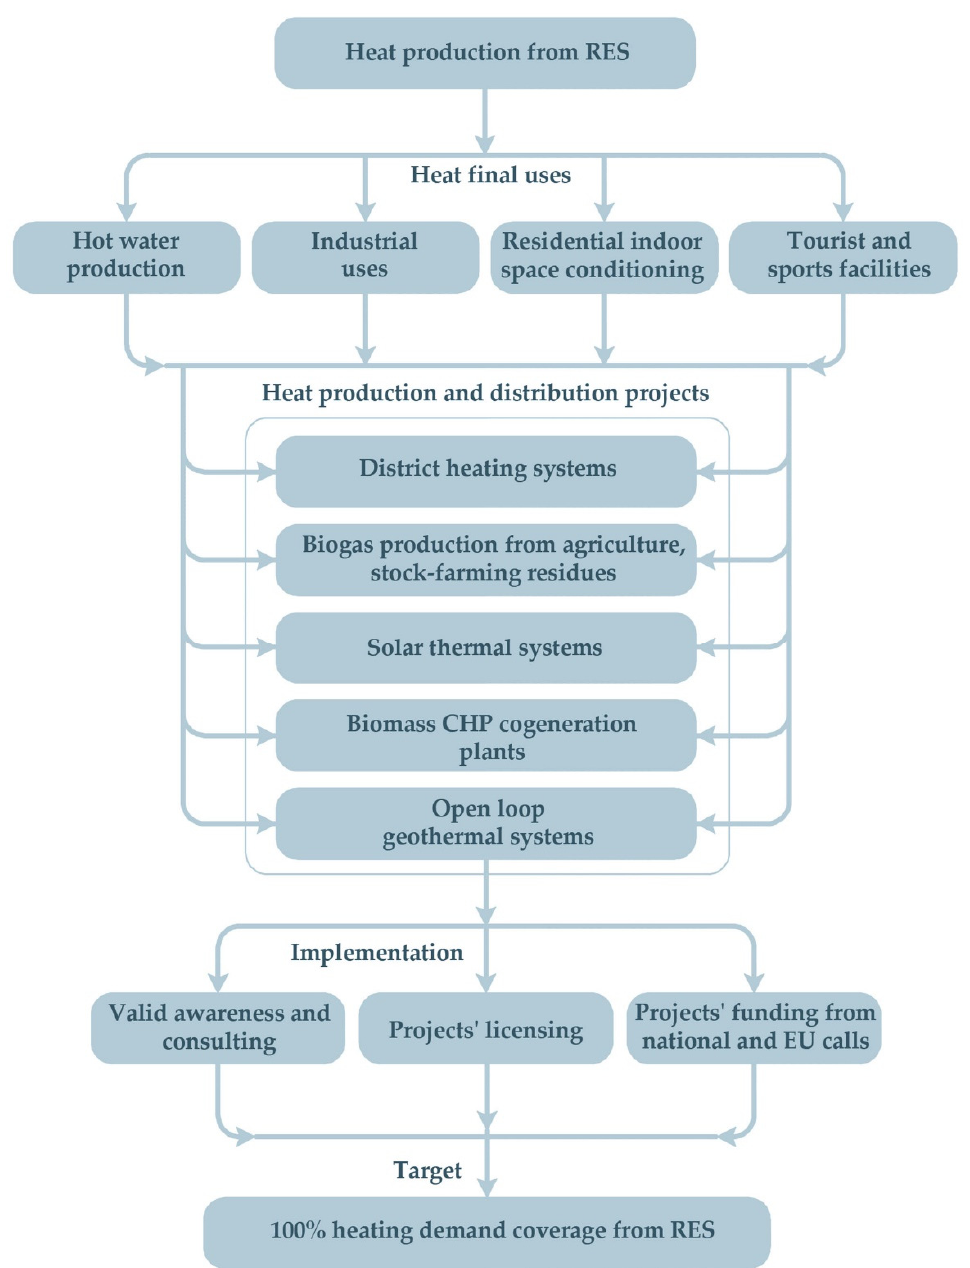
Figure 18. Target and route for the 100% coverage of heating and cooling needs from Renewable Energy Sources (RES).